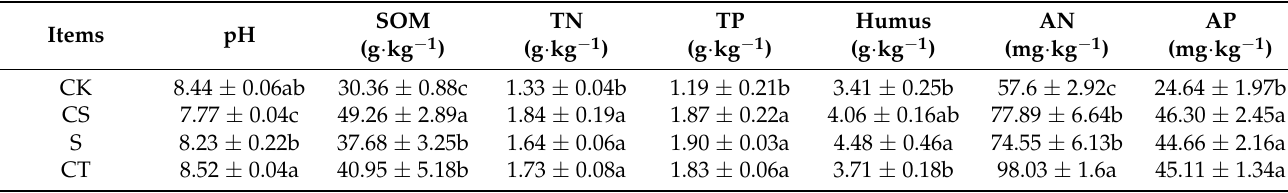
Table 1. Soil properties under different fertilization